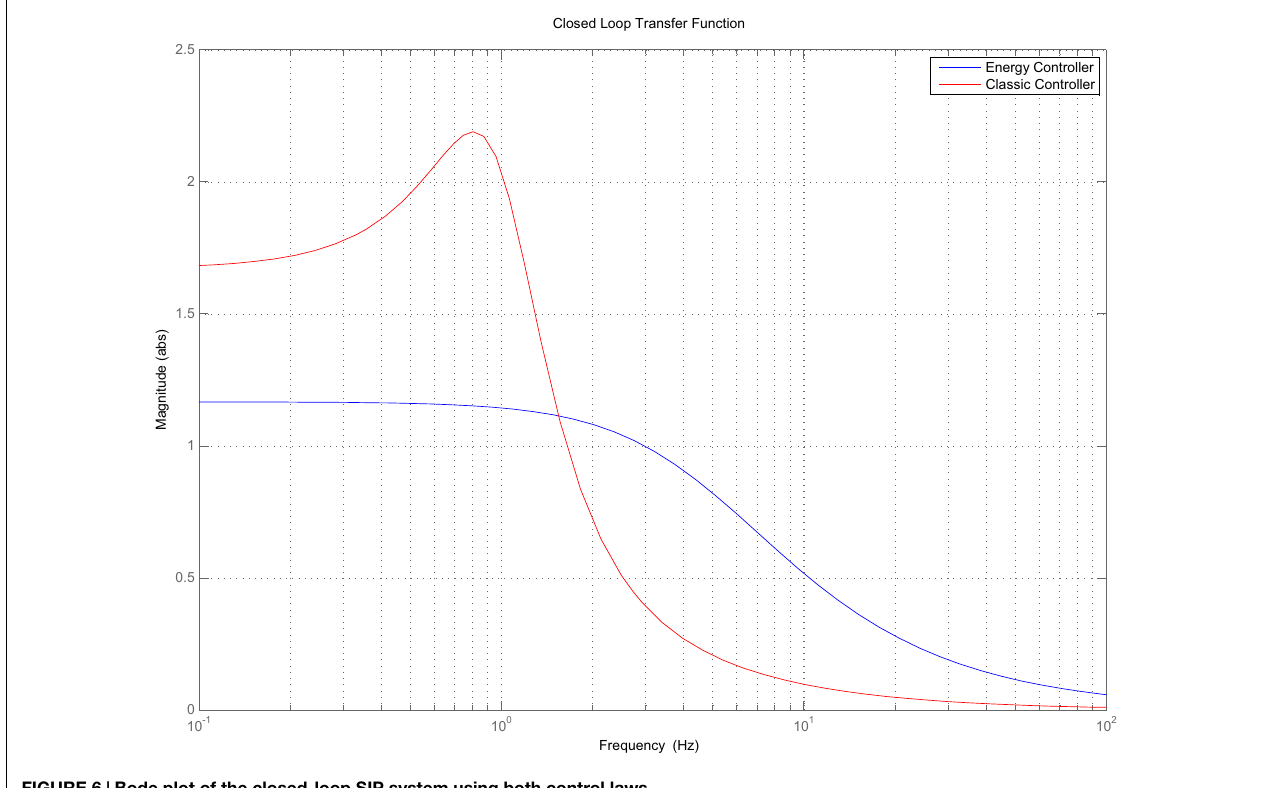
FIGURE 6 | Bode plot of the closed-loop SIP system using both control laws .